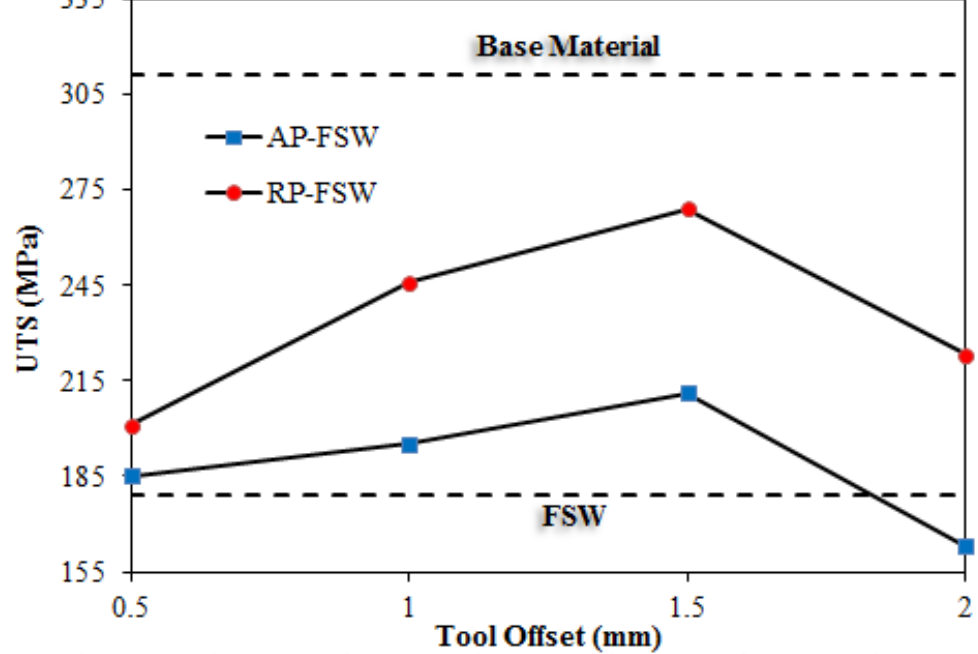
Figure 9. Comparison of UTS values of welded specimens with FSW, AP-FSW, and RP-FSW techniques.